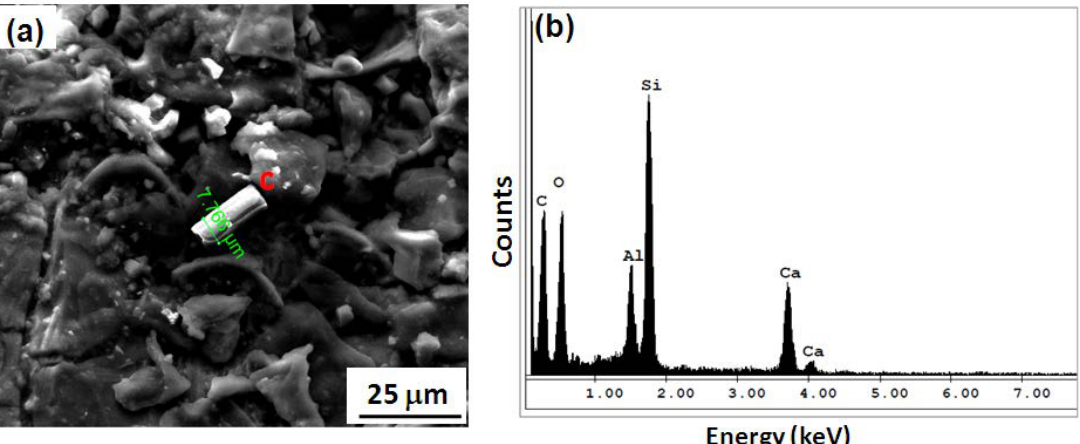
Figure 10: SE SEM image: (a) fibre particle c in damaged portion of the antenna (location A) and (b) EDS pattern corresponding to fibre particle